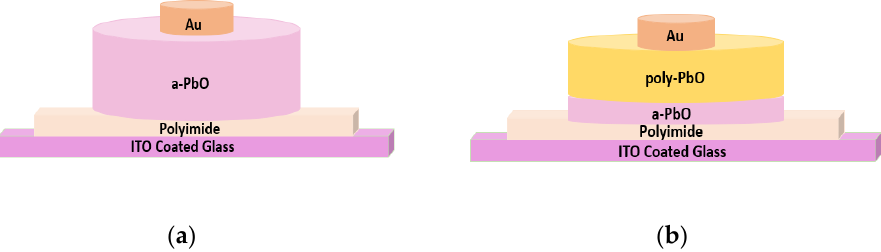
Figure 1. Schematic of ( a ) PI/a-PbO multilayer detector structure, ( b ) PI/a-PbO/poly-PbO multilayer detector structure (schematics not to